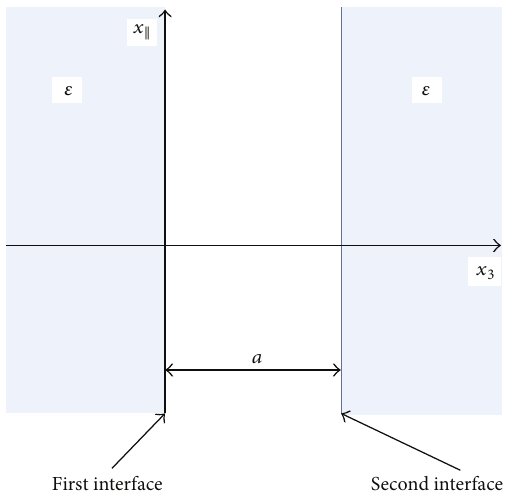
Figure 1: The configuration of two interfaces separated by a gap of width 𝑎